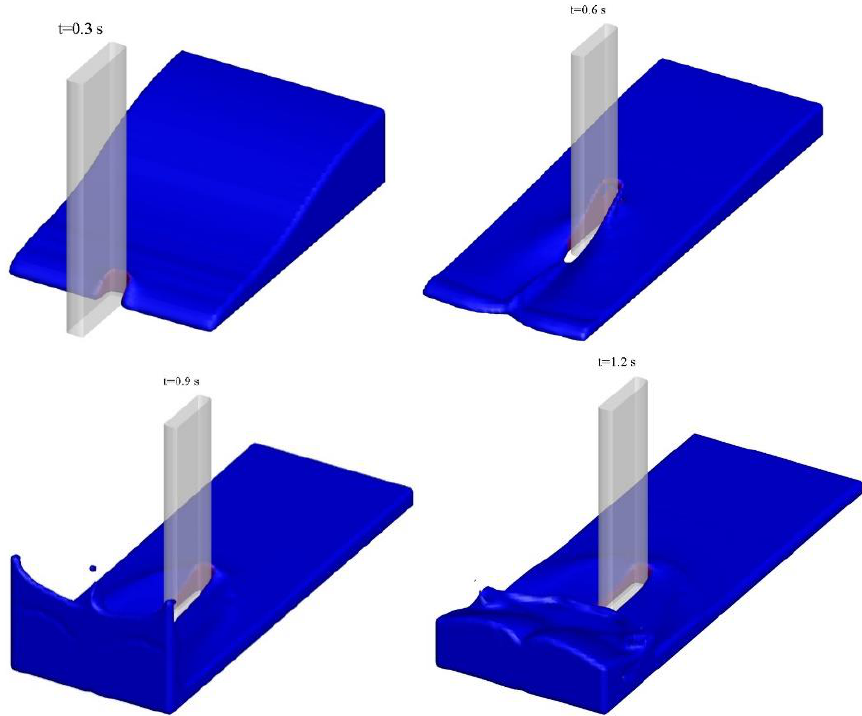
Figure 7. Simulation of the 3D dam-break flows over a vertical rectangular obstacle ( α = 0.25 ).